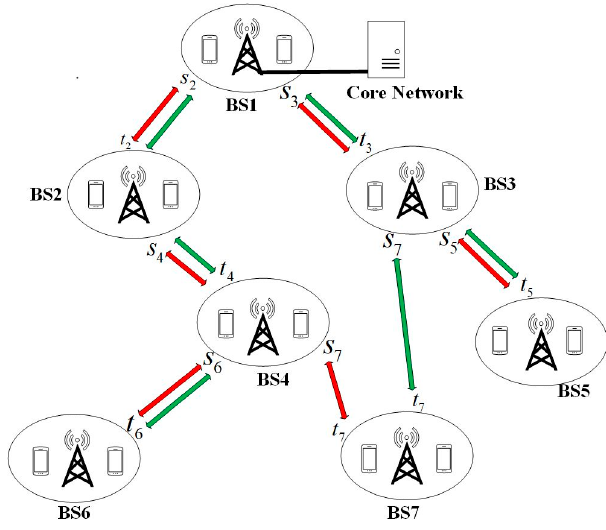
Figure 1. Example of utility-based wireless backhaul routing (UWBR) .